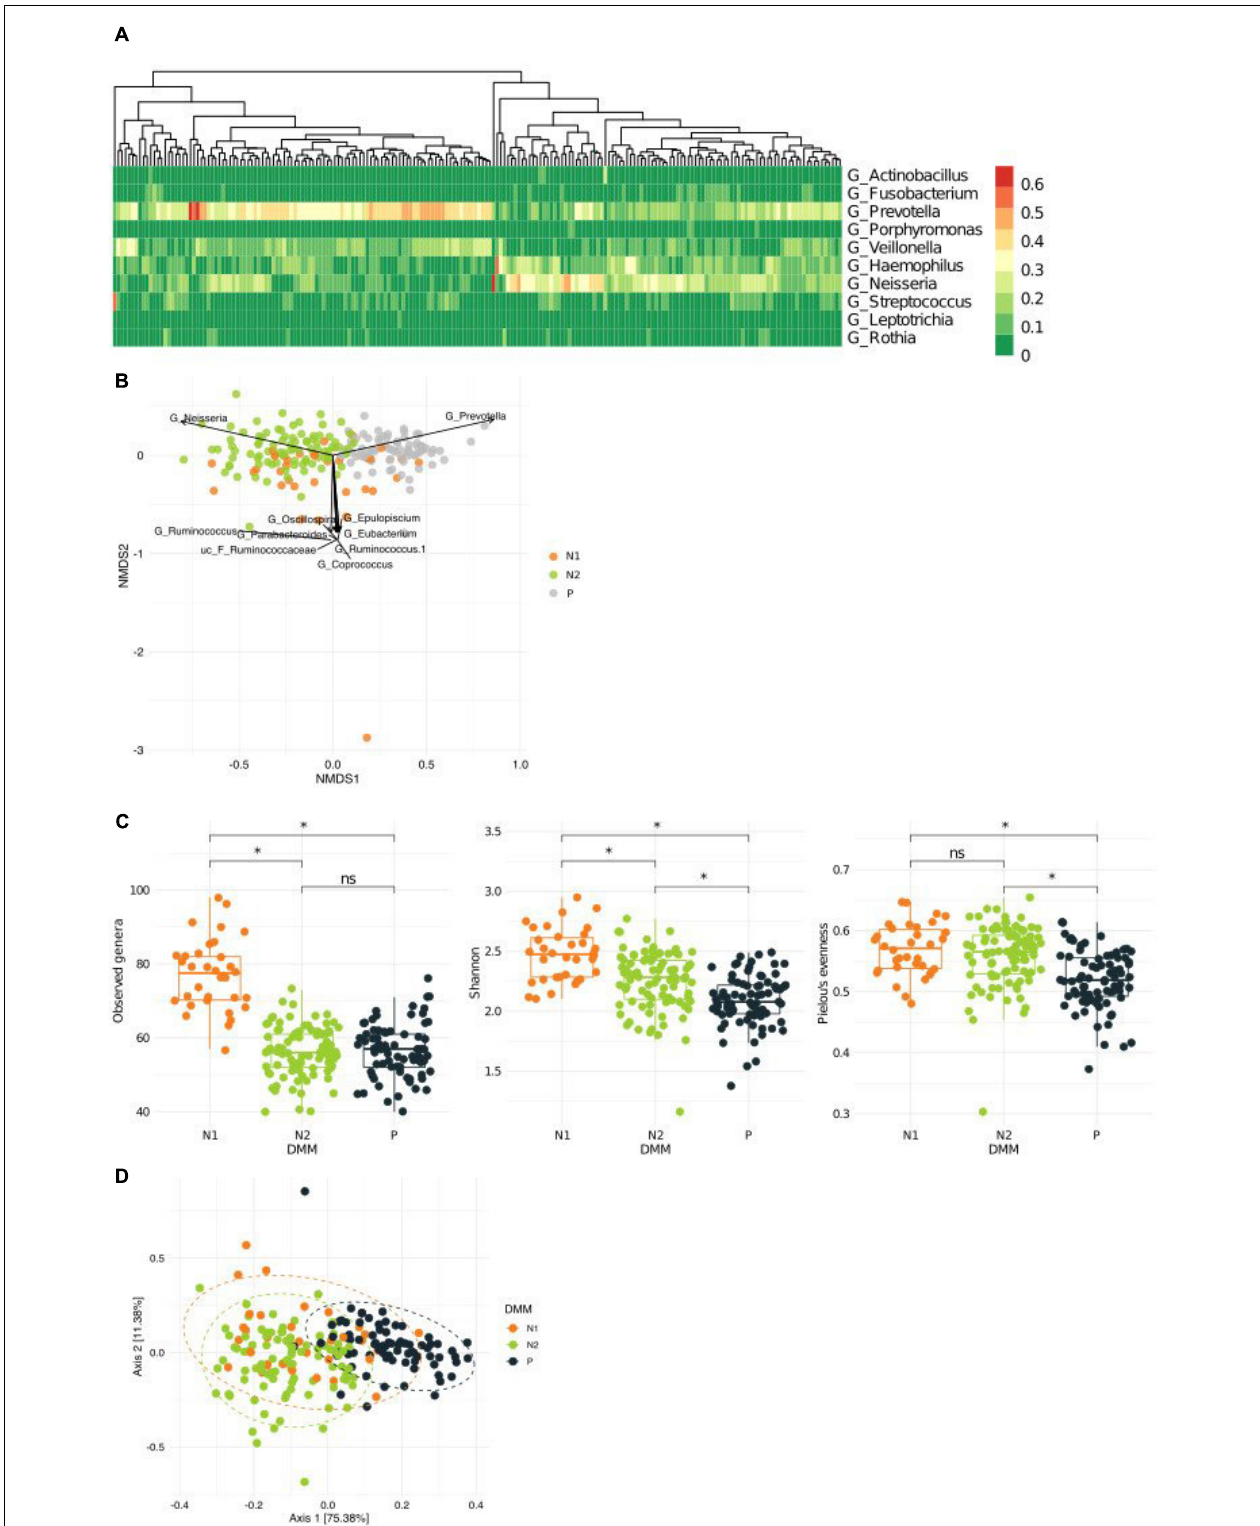
FIGURE 1 | Variations in the microbiota in sputum samples collected from a healthy Korean cohort. (A) Heatmap showing the top 10 most abundant bacteria in the sputum microbiota. (B) A non-metric multidimensional scaling (NMDS) plot in which metacommunities are assigned a color. Arrows indicate the top 10 bacteria contributing to community variation. (C) Metacommunity diversity at the genus level. (D) Different inferred functional characteristics of the sputum microbiome among metacommunities. A principal coordinates analysis (PCoA) plot showing the distribution of functional features of metacommunity. * q < 0.001. Frontiers in Microbiology |